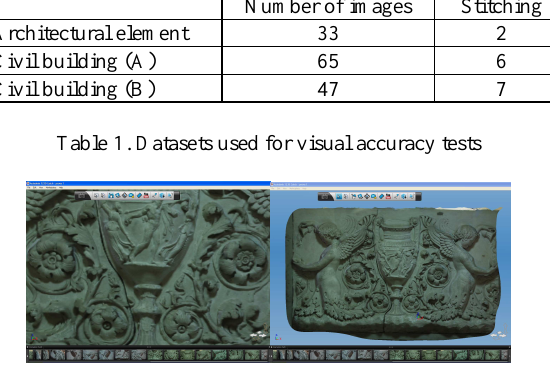
Figure 2: The photographic sequence needed for the acquisition of an architectural element.